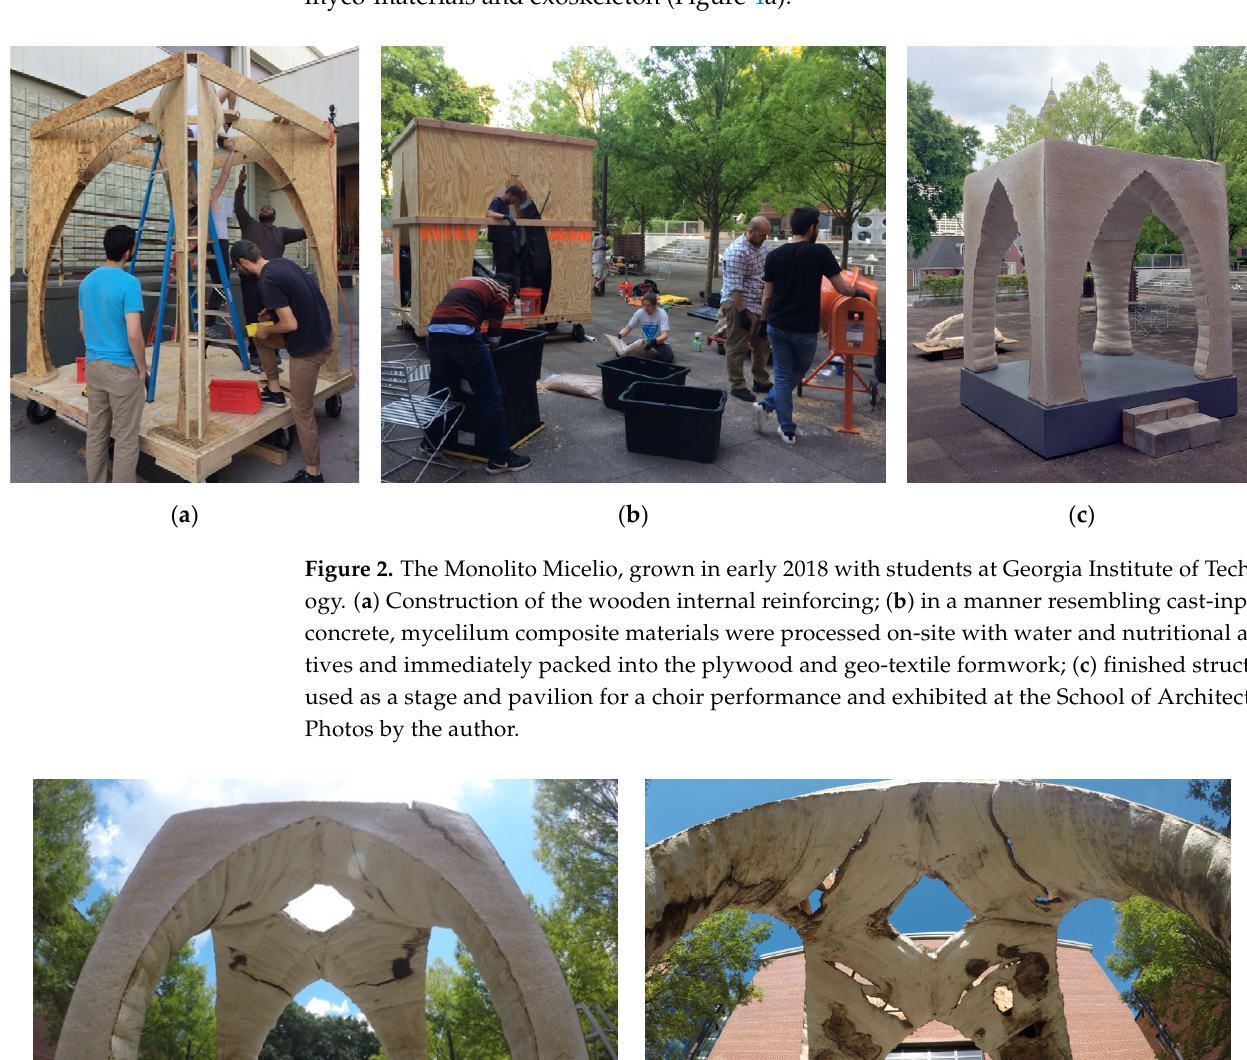
Figure 2. The Monolito Micelio, grown in early 2018 with students at Georgia Institute of Technol- ogy. ( a ) Construction of the wooden internal reinforcing; ( b ) in a manner resembling cast-inplace concrete, mycelilum composite materials were processed on-site with water and nutritional addi- tives and immediately packed into the plywood and geo-textile formwork; ( c ) finished structure, used as a stage and pavilion for a choir performance and exhibited at the School of Architecture. Photos by the author.